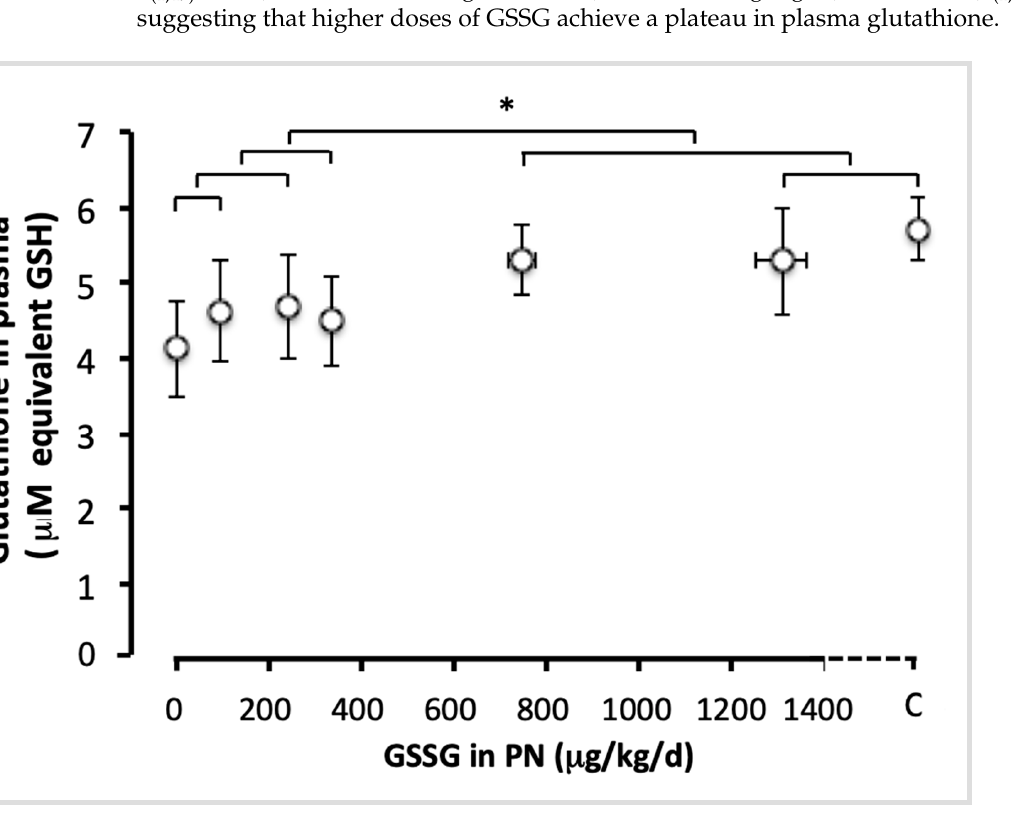
Figure 1. Total glutathione in plasma as a function of increasing doses of GSSG added to PN. The control (C) value was added to the abscissa after the highest dose of GSSG. Total glutathione: GSH + GSSG, expressed as GSH equivalent. The orthogonal comparisons were 0 vs. 95 µg/kg/d (no sta- tistical difference), the two vs. 240 µg/kg/d (no difference), the first three doses vs. 330 µg/kg/d (no difference). The highest doses were not statistically different from the control: C versus 1300